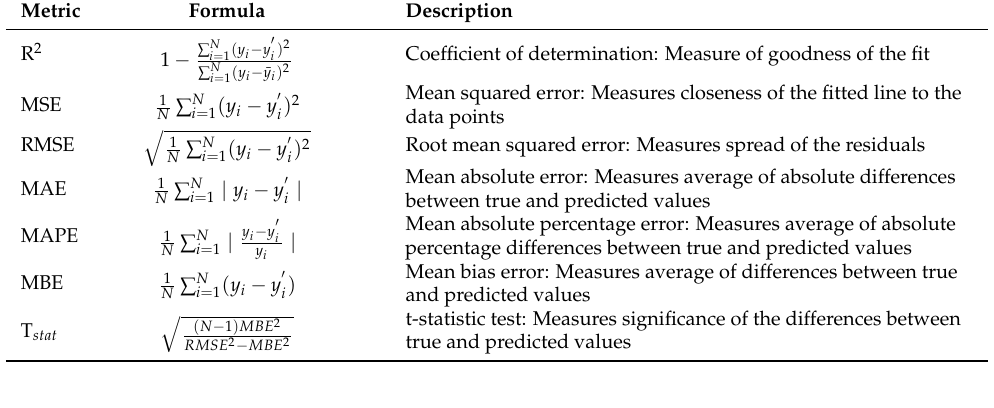
Table 4. Performance parameters used in the proposed method.